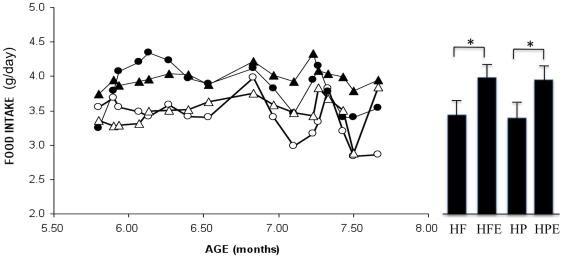
Comparison of food intake between groups.Food consumption was measured 3 times per week in all groups by weighing chow pellets and calculating mean consumption for each group (n = 10). Open circles: high protein (HP) sedentary; closed circles: HP-exercise; open triangles: high fat (HF) sedentary; closed triangles: HF exercise. Bars on right are mean of total food intake during the exercise period ± SEM; both exercise groups consumed significantly more chow than the sedentary groups; p<0.01 by Mann-Whitney U test.